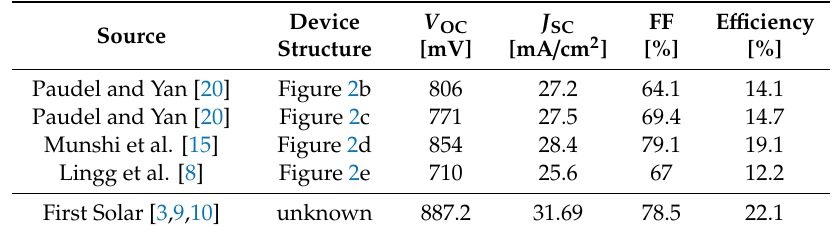
Table 2. J - V parameters of the best CdTe 1 − x Se x -containing devices for each configuration shown in Figure 2.